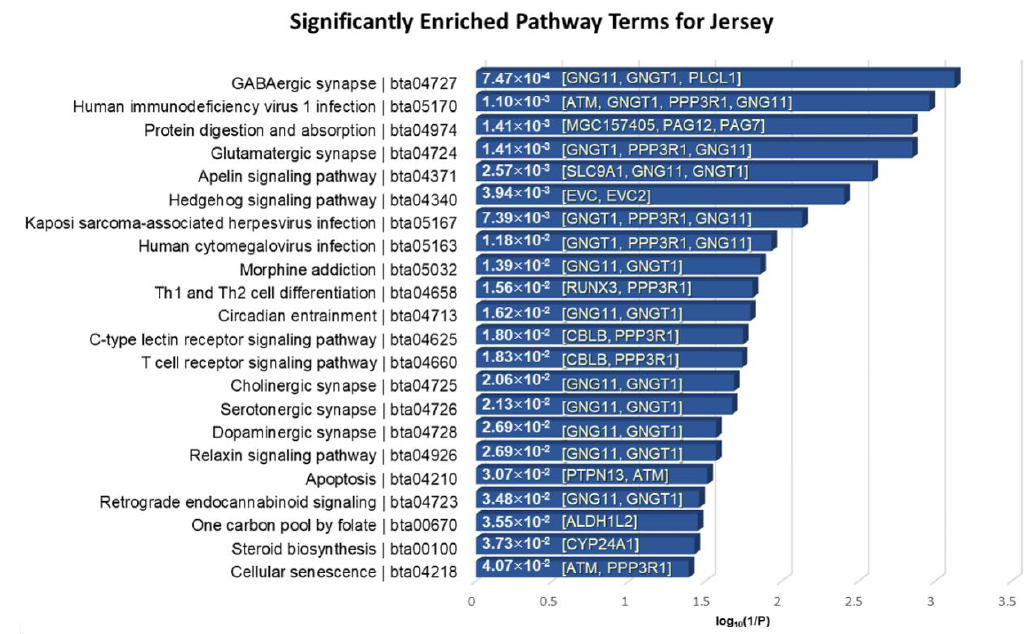
Figure 8. KEGG pathway enrichment analysis of the 55 overlapped genes in Jersey breed. The x -axis indicates the log10(1 / p -value), and the annotated genes of the enriched pathways with significant p -values shown in bar graphs.